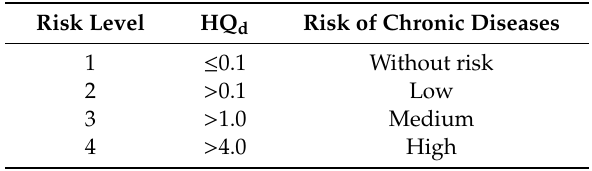
Table 5. Scale for classifying the level of risk of chronic